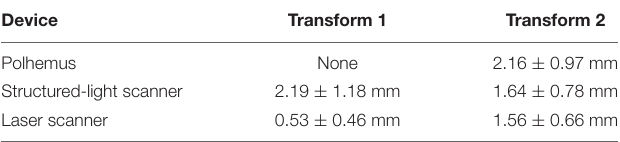
TABLE 4 | Surface fit error of each device in the human experiment.